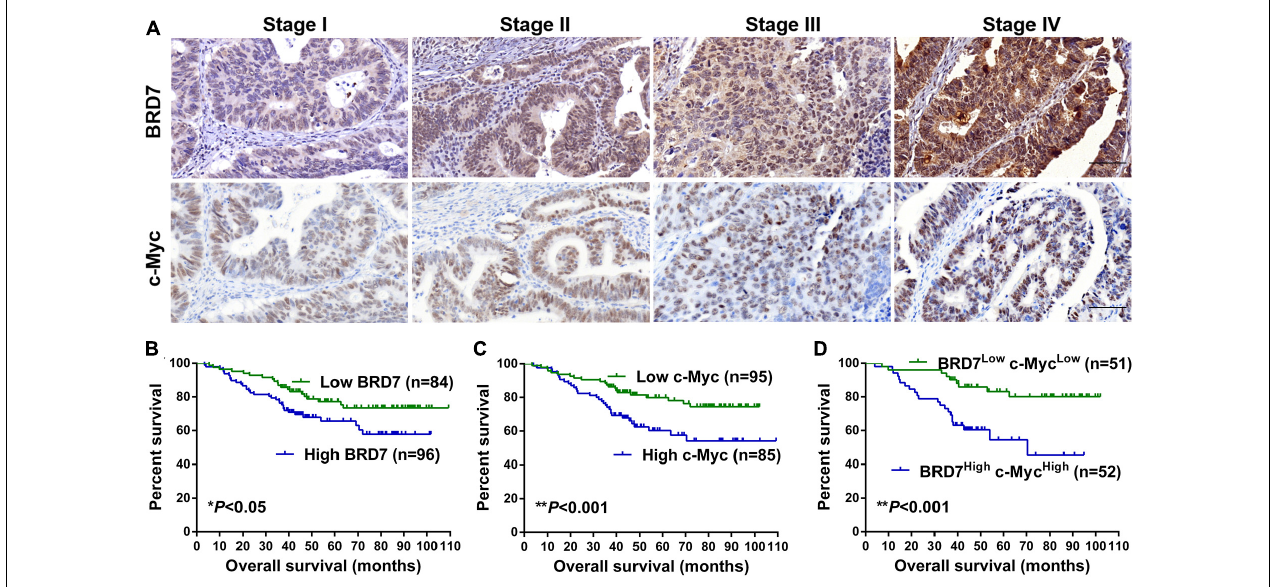
FIGURE 7 | The expression and clinical significance of BRD7 and c-Myc in colorectal cancer (CRC) patients. (A) The expression of BRD7 and c-Myc protein in patients with different clinical stages of CRC, as detected by immunohistochemistry (IHC). Scale bar: 100 µ m. (B–D) Kaplan–Meier analysis was used to plot the overall survival (OS) curve of CRC patients according to the expression of BRD7 and c-Myc.